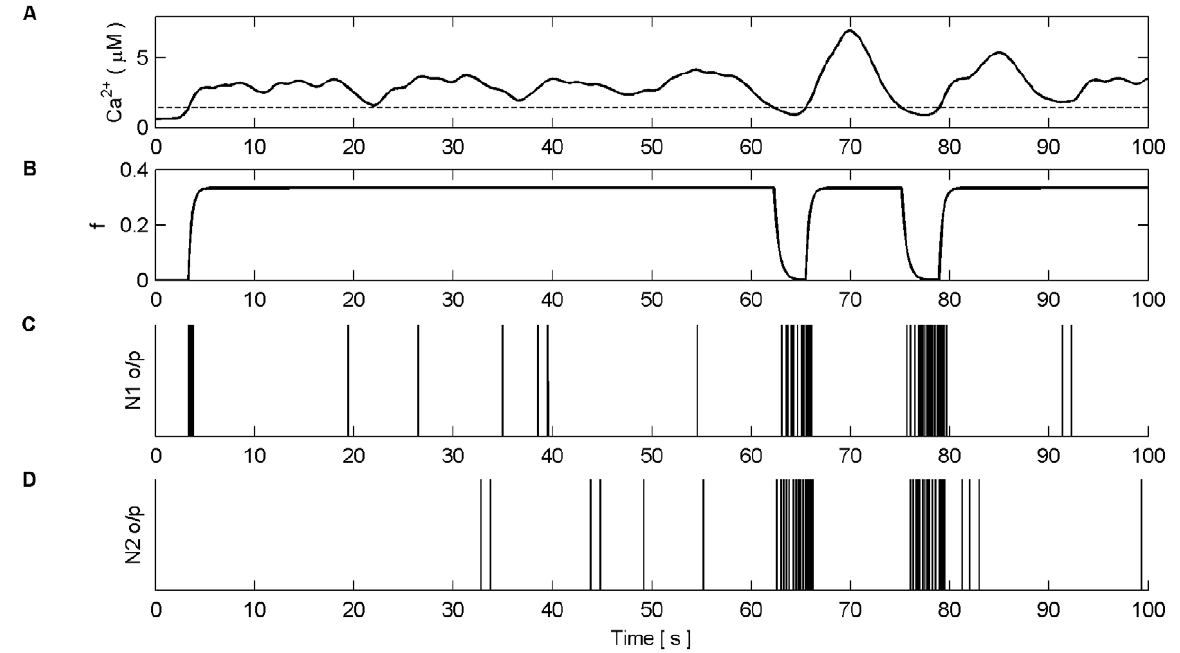
Figure 22. Total Ca 2 + oscillation and neural firing activity in the AM-FM mode. (A) Total Ca 2 + oscillation and Ca 2 + threshold (dashed line). (B) f function. (C) Neural firing activity of N1. (D) Neural firing activity of N2. Note how total Ca 2 + is much more erratic and infrequently crosses the threshold from above and below. Although the f function is activated for much longer periods, negative feedback is still unable to cause phase locking. As a result the coordinated bursting activity of N1 and N2 is significantly reduced.